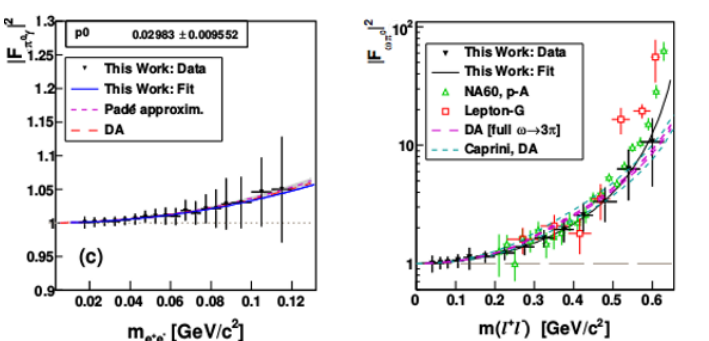
| 2 results with total uncertainties. The fitted values to the points are shown by blue lines, Figure 1. (left) | F π 0 γ with p 0 being the slope parameter a π . Comparison to calculations with Padé approximants [26] is seen as the short-dashed magenta line with a gray error band and to the dispersive analysis (DA) [27] shown as the red, long-dashed line. The error band for the latter analysis is by a factor of four narrower, compared [26], and is omitted. (right) | F ( m e + e − ) | 2 results (black filled triangles) fitted with the pole approximation (black solid ωπ 0 line). The experimental results from Lepton-G [38] (open red squares) and NA60 in p–A collisions [30] (open green triangles) are shown together with dispersive analysis calculation by the Bonn group [40] (magenta dashed lines) and upper and lower bounds by Caprini [41] (cyan dashed lines) for the discontinuity calculated with the partial-wave amplitude f 1 ( t ) based on